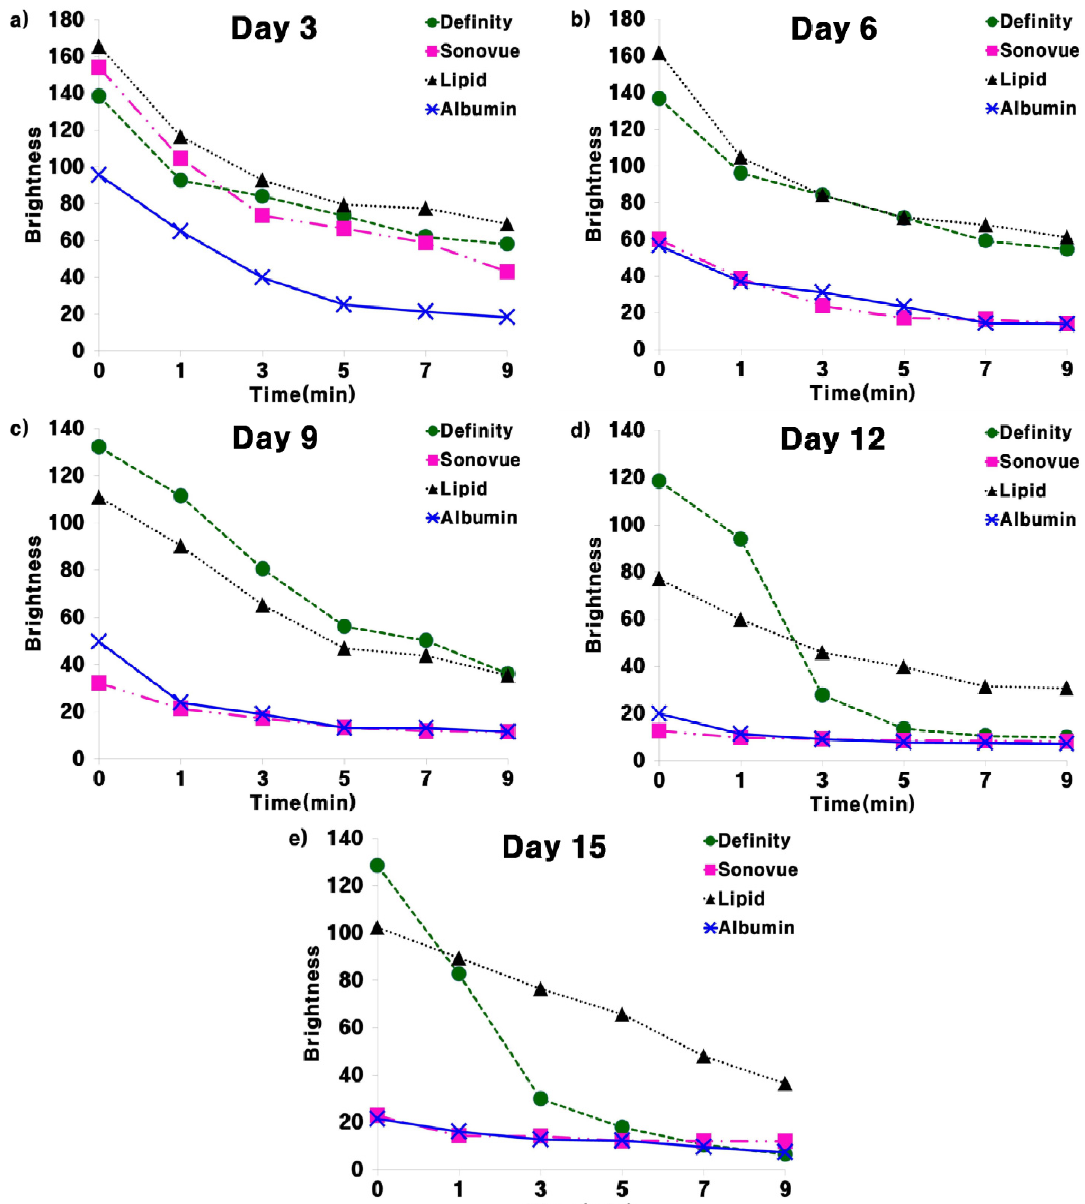
Figure 8. UCA lifespan. All the UCAs seem to have limited lifespan in the case of bolus injection. Additionally, the preservation period of all of the UCAs seems to be less than six days. SonoVue ® and albumin shelled UCAs seem to decay faster after opening the vial or